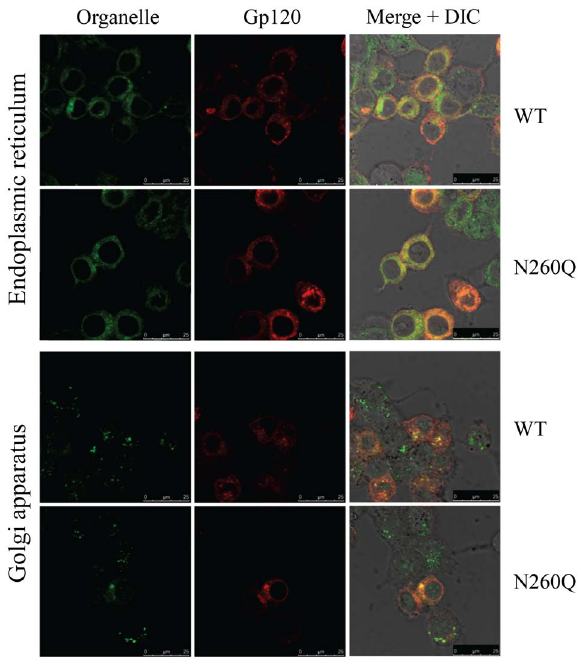
Figure 1. Intracellular staining of HIV-transfected HEK293T cells. The ER and Golgi apparatus (green) were labelled with an anti- PDI and an anti-giantin antibody, respectively. Gp120 (red) was visualized with antibody 2G12. Overlay of gp120 and the ER or Golgi is shown as orange/yellow.